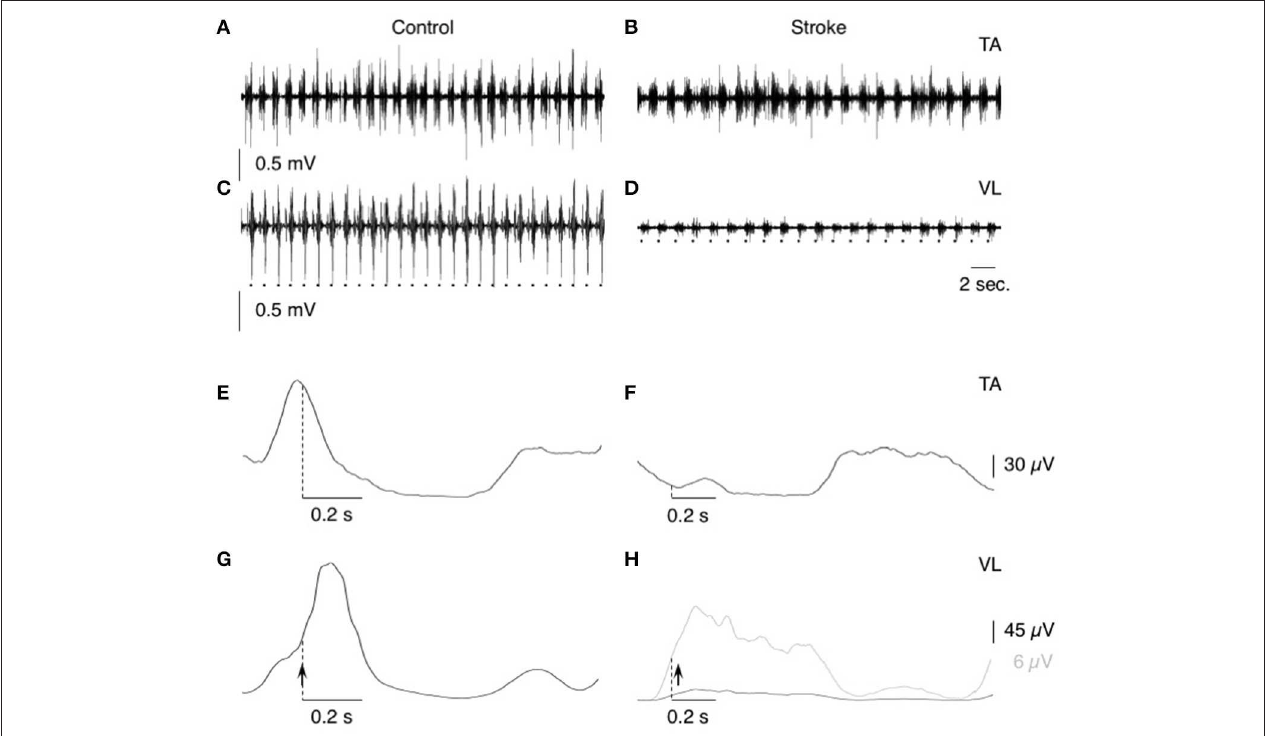
FIGURE 1 | EMG activities during treadmill walking. (A–D) Raw EMG activity during treadmill walking in tibialis anterior (TA; A,B ) and vastus lateralis (VL; C,D ) in one control (speed 1m.s − 1 ; A,C ) and one patient (speed 0.33m.s − 1 ; B,D ). The dots at the bottom indicate the time of heel contact. (E,F) the raw EMG activities have been rectified and 50-ms smoothed before averaging ( N = 50 steps) in tibialis anterior (TA; E,F ) and vastus lateralis (VL; G,H ) in the same individuals as in (A–D) . In (H) the gray line represents the mean EMG activity with optimized Y-scale for the patient. Dotted vertical lines indicate the time of heel contact, and vertical arrows, when the conditioning stimuli were delivered during the gait